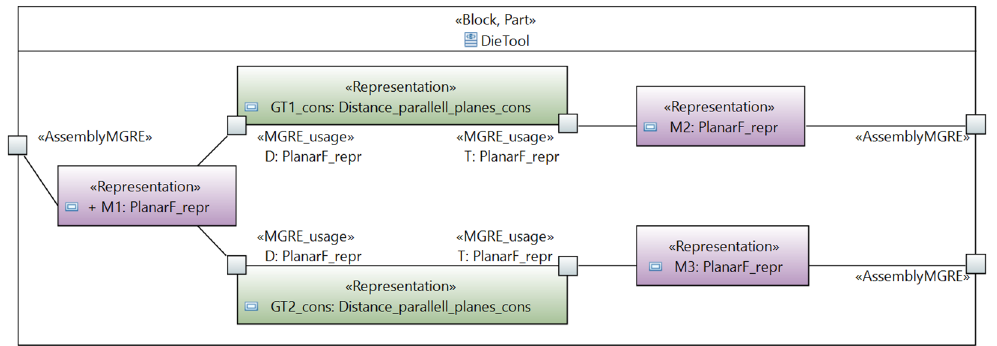
Figure 19. IBD to represent the TTRS ‐ based internal structure of DieTool Block.